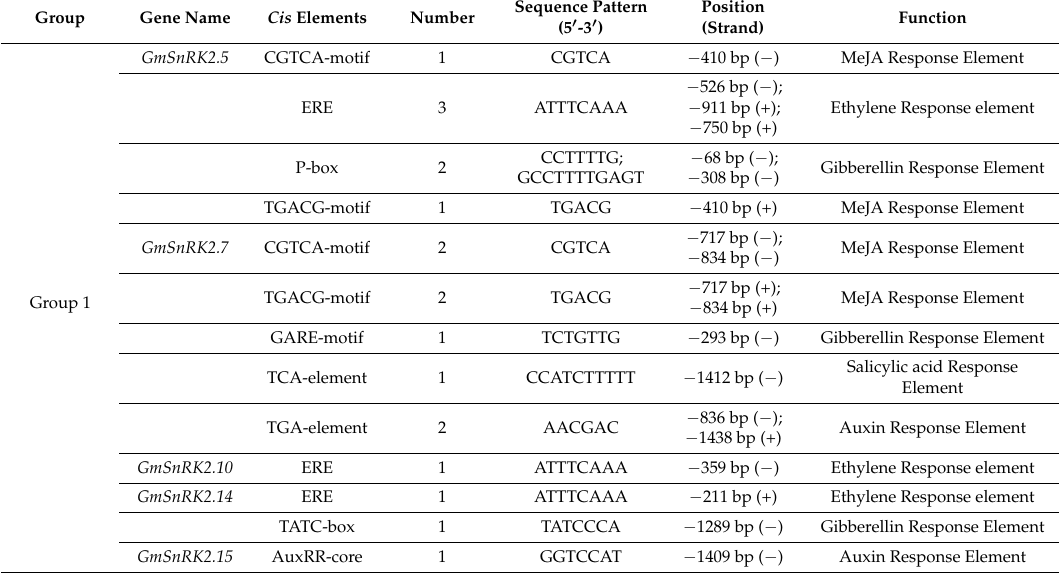
Table 2. Phytohormone response elements in the promoters of GmSnRK2s